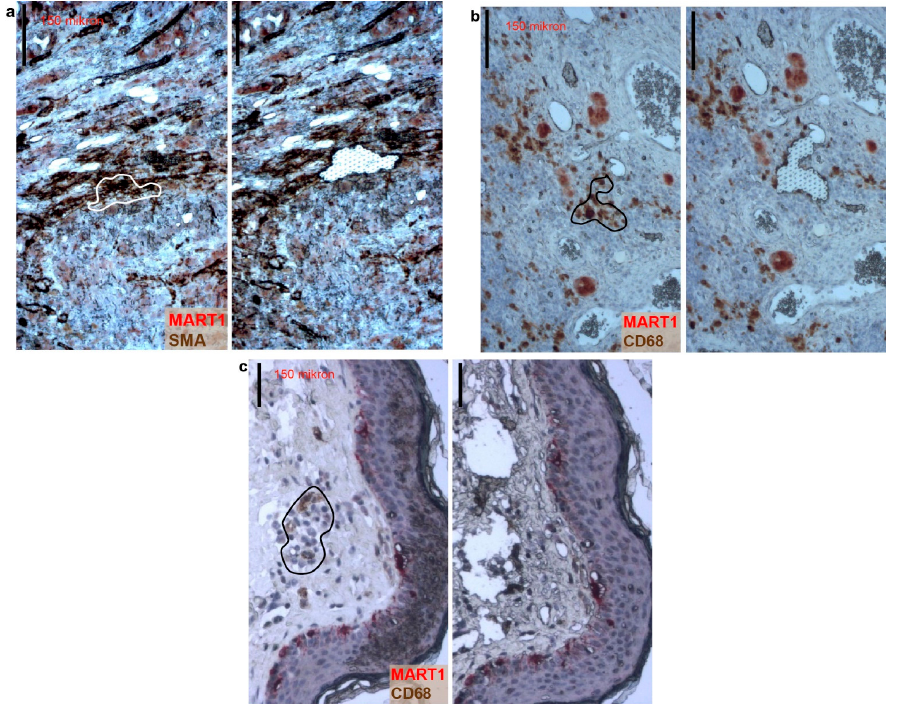
Figure 2. Peritumoral stromal cells contain the melanoma-derived oncogenic BRAF V600E at the genomic level. ( a ) BRAF V600E melanoma tissue sample stained for MART1 (red), smooth muscle actin (SMA) (brown), and hematoxylin (blue) before ( left panel) and after ( right panel) laser-capture microdissection of MART1 − /SMA+ fibroblasts (white line); ( b , c ) Tissue samples of BRAF V600E ( b ) primary melanoma and ( c ) melanoma metastasis stained for MART1 (red), CD68 (brown), and hematoxylin (blue) before ( left panels) and after ( right panels) laser-capture microdissection of MART1 − /CD68+ macrophages (black line). Black bars indicate 150 µm.